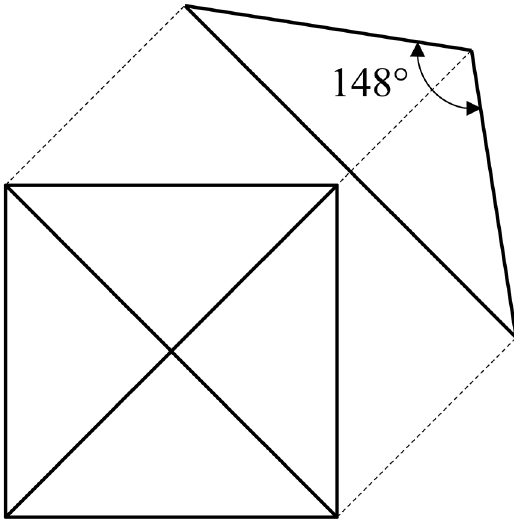
Figure 3: Angle between edges of Vickers indenter 17 .